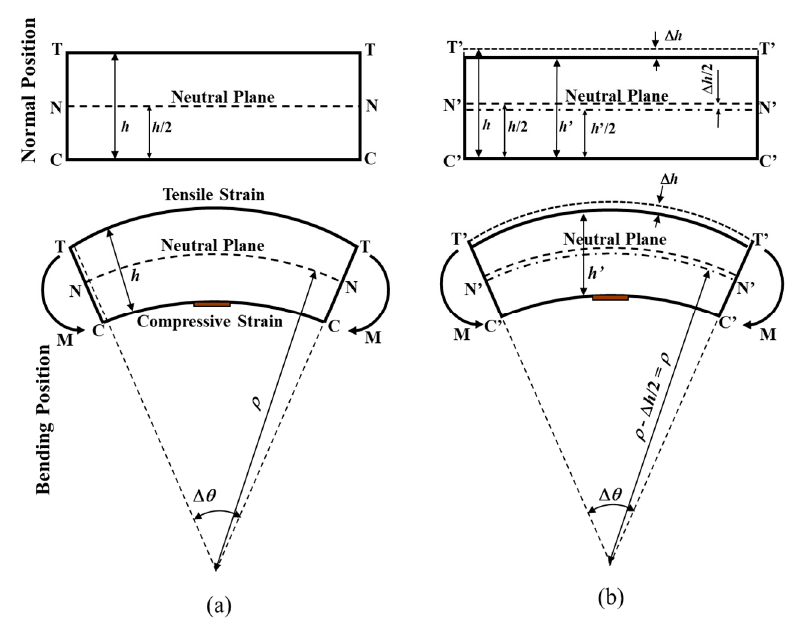
Figure 1. Illustration of ( a ) a non-corroded test piece, and ( b ) a corroded test piece highlighting the geometry of the normal and bending positions.